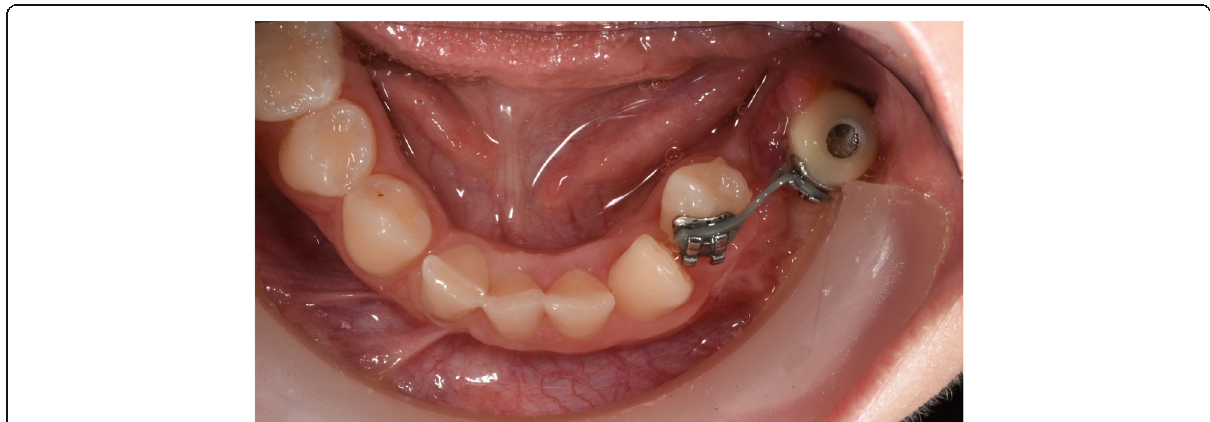
Fig. 8 Patient 2 — intra-oral situation during orthodontic treatment at the age of 14. A temporary crown with bracket is fixed on the dental implant. Eight months after start of orthodontic treatment, the 34 is already close to the planned end position